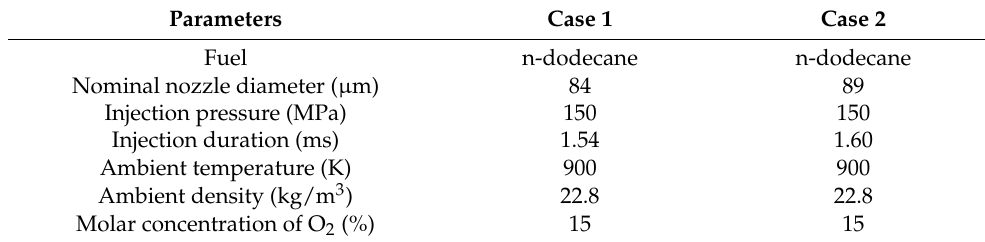
Table 2. Operating conditions of Spray A from the ECN website